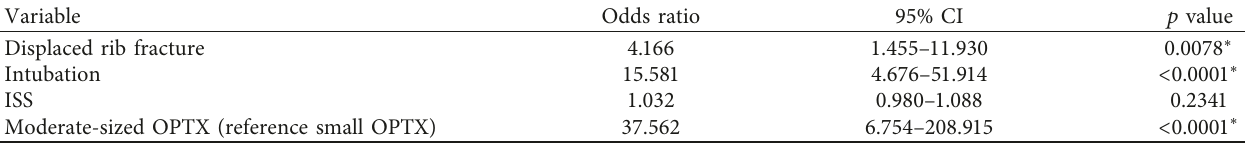
Table 2: Multivariable logistic regression analysis of factors associated with chest tube